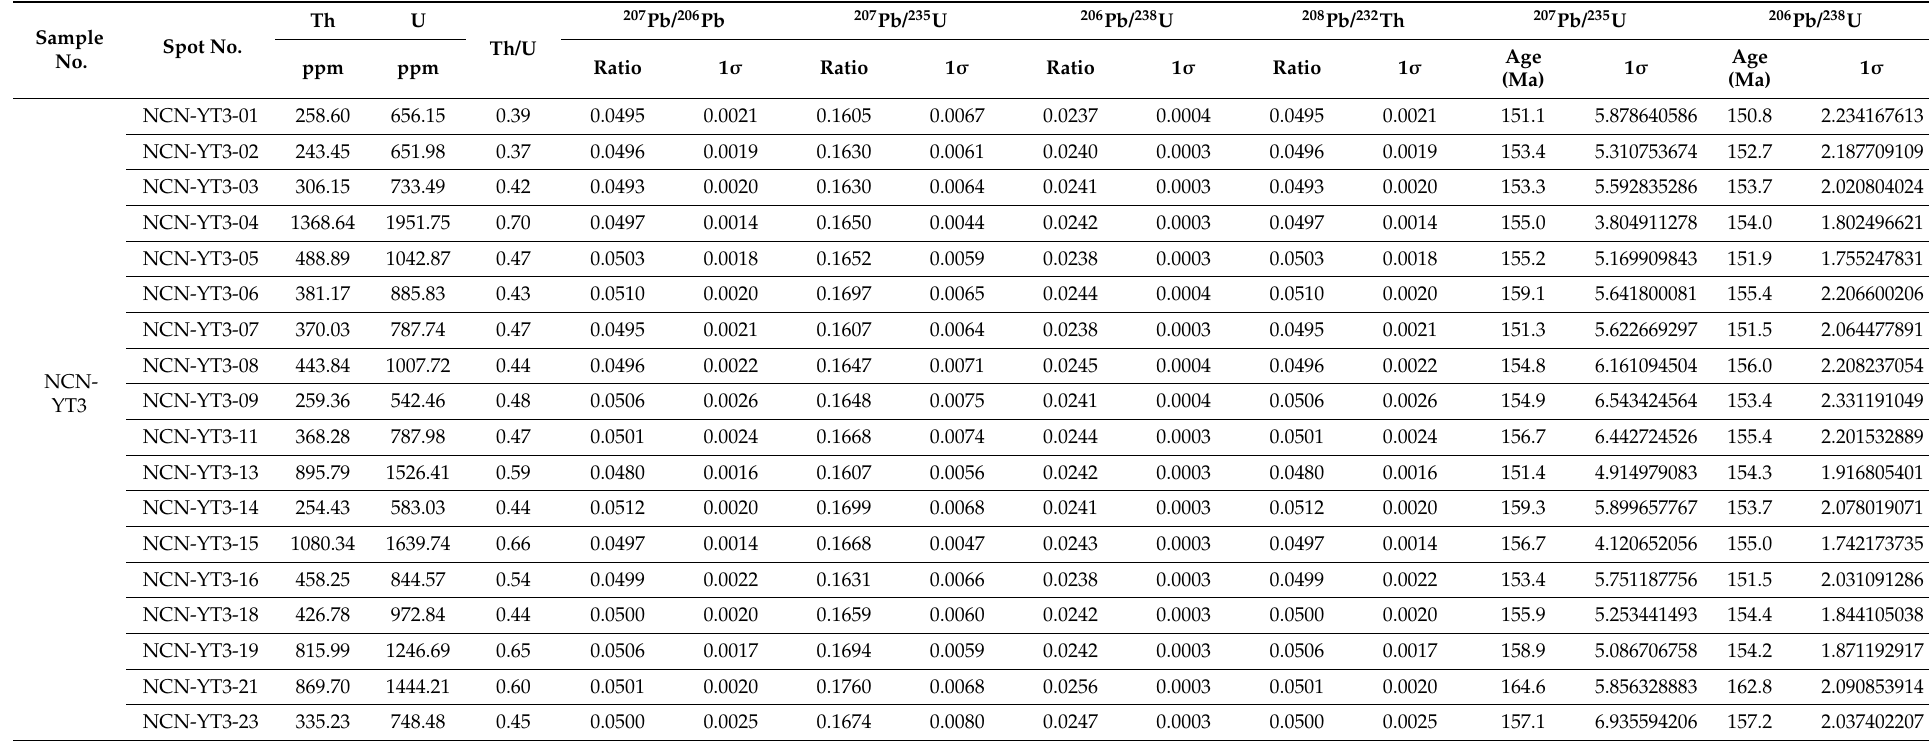
Table 1. Zircon LA-ICP-MS U-Pb dating result of Nuocang granodiorite. Sample